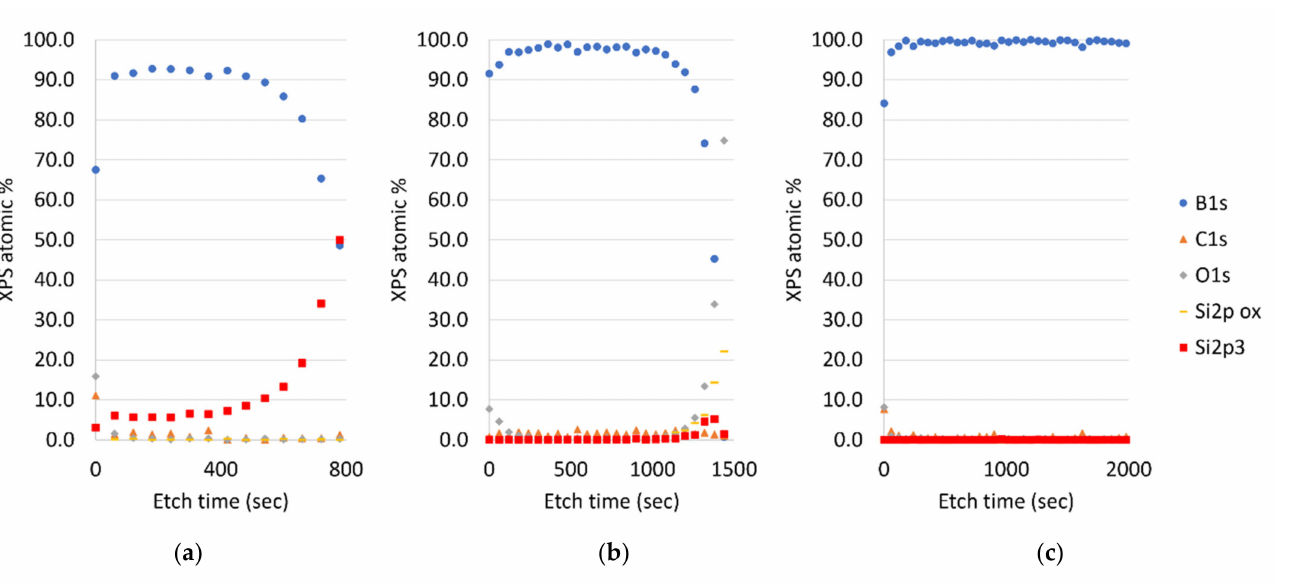
Figure 1. XPS depth profiles of boron thin films realized in this work by ( a ) atmospheric pressure CVD, ( b ) magnetron sputtering, ( c ) plasma enhanced